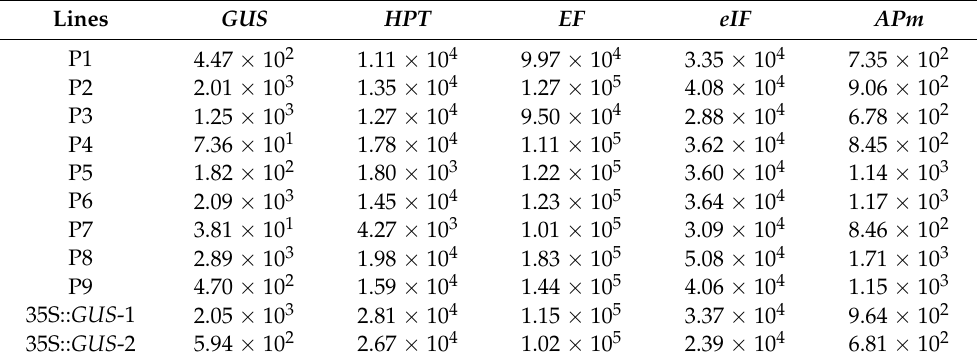
Table 3. Transcript abundance of GUS , HPT , EF , eIF, and APm by qRT-PCR in stably transformed